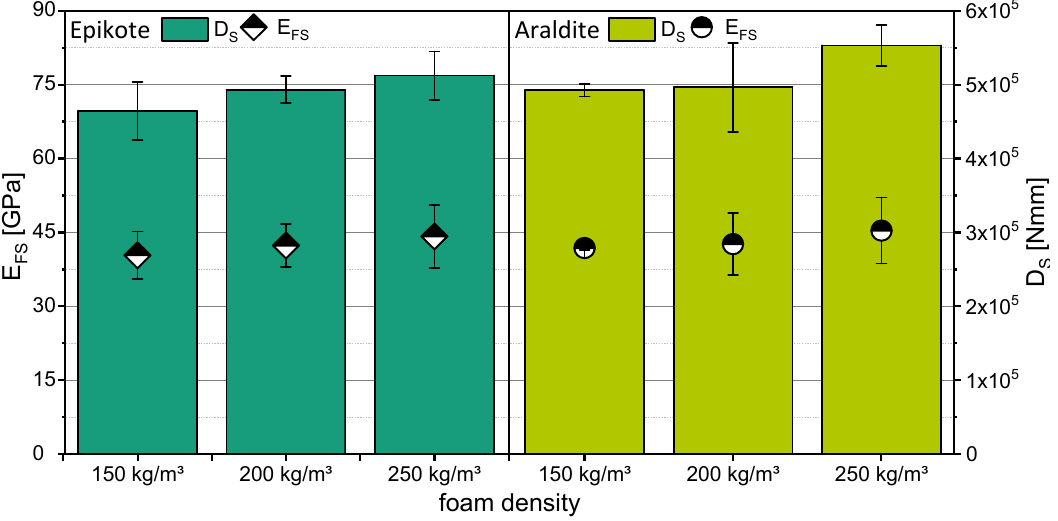
Figure 6. Face sheet stiffness, determined in tensile tests E FS (dot plot) and the resulting bending stiffness D S (bar graph) for the Epikote ( left ) and the Araldite ( right ) resin systems.